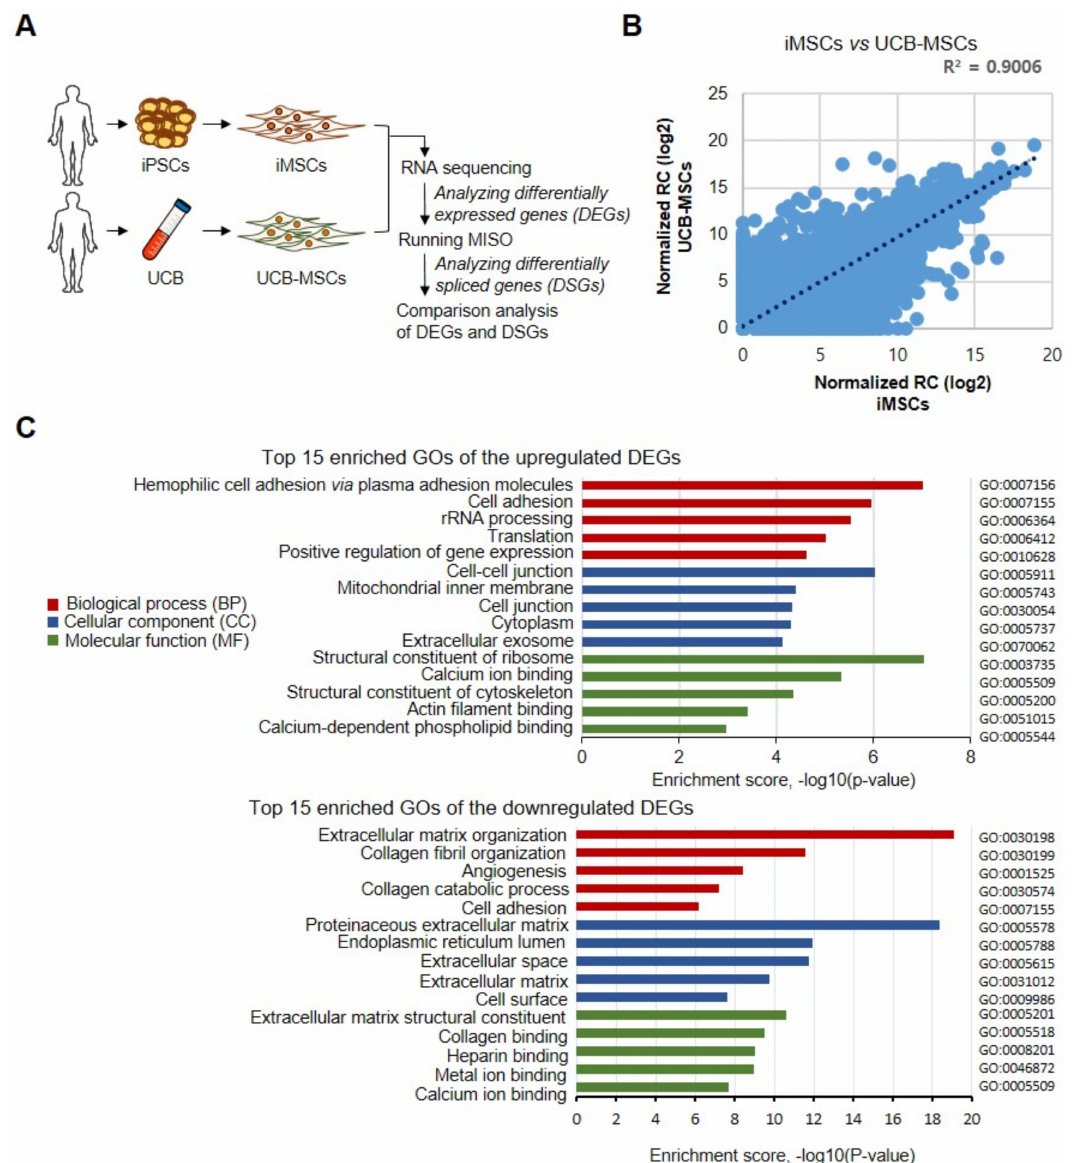
Figure 1. Comparative analysis of DEGs between iMSCs and UCB-MSCs. ( A ) A schematic view of the experimental design of comparative transcriptomic analysis by RNA-Seq for comparison of iMSCs versus UCB-MSCs. ( B ) Scatter plots show correlations between iMSCs and UCB-MSCs. R2 indicates the coefficient of determination. ( C ) The top 15 GO terms of up- regulated and down-regulated DEGs. GO analysis classified the DEGs into three groups: red, biological process; blue, cellular component; and green, molecular function. The x-axis indicates the enrichment scores [-log10 ( p value), p -value cut-off of 0.05] for each GO term. The y-axis represents the detailed classification of the GO or KEGG pathway